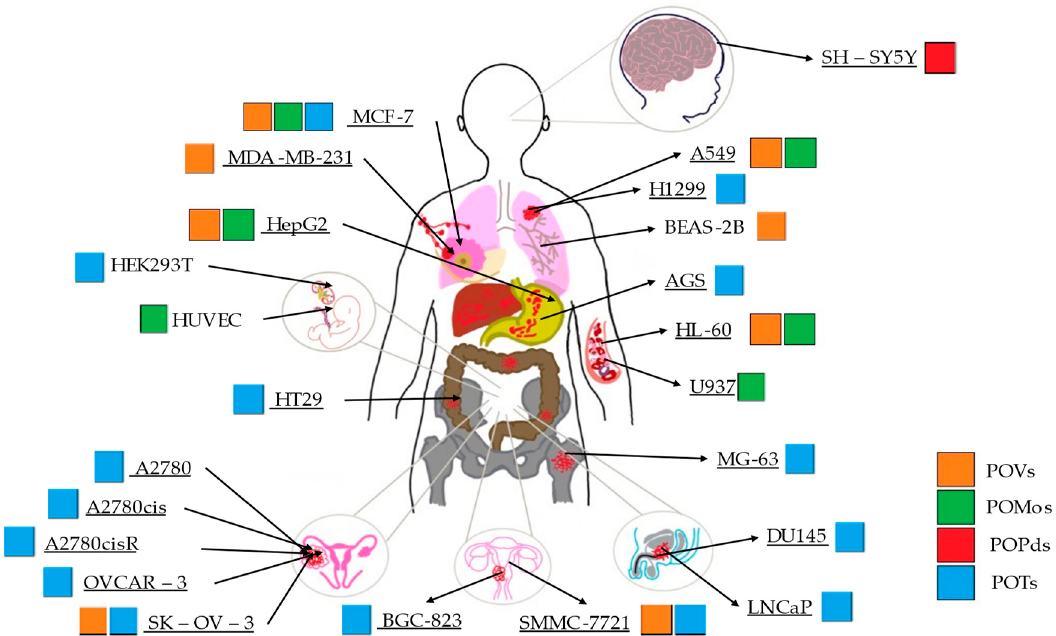
Figure 4. Illustration of the 23 human cell lines tested in the study of cell viability of different types of POMs. A total of 20 tumor lineages are underlined and 3 are not underlined, which are non-tumor cell lines. The color scheme is representative of each type of POM studied: POVs in orange, POMos in green, POPds in red and POTs in blue.